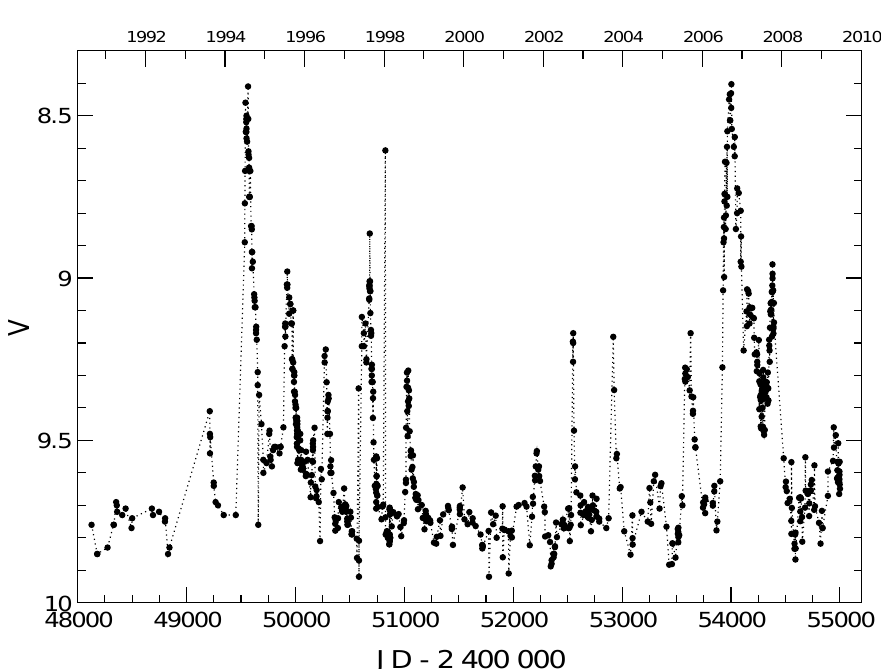
Fig. 1. V light curve of AG Dra between 1991{2009. The observations have been collected from the literature as explained in Section